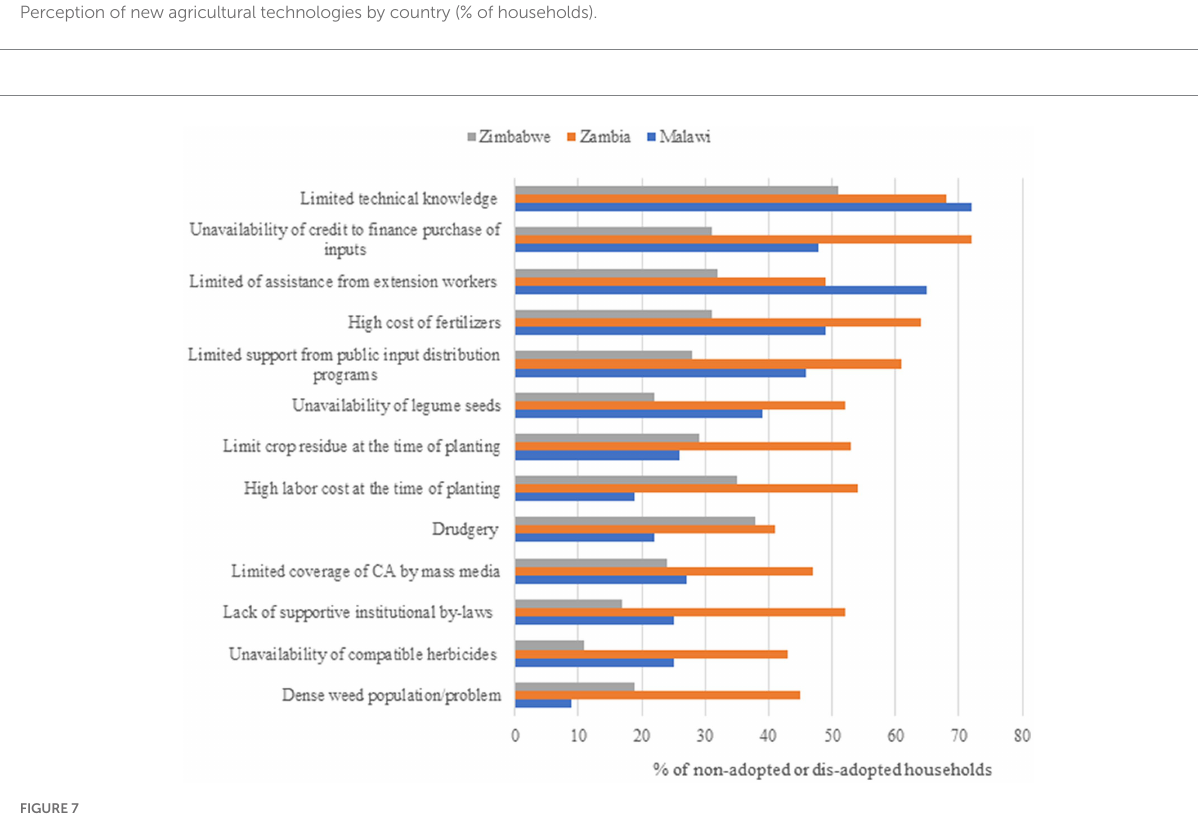
FIGURE 7 The reasons for non-adoption and dis-adoption of CA